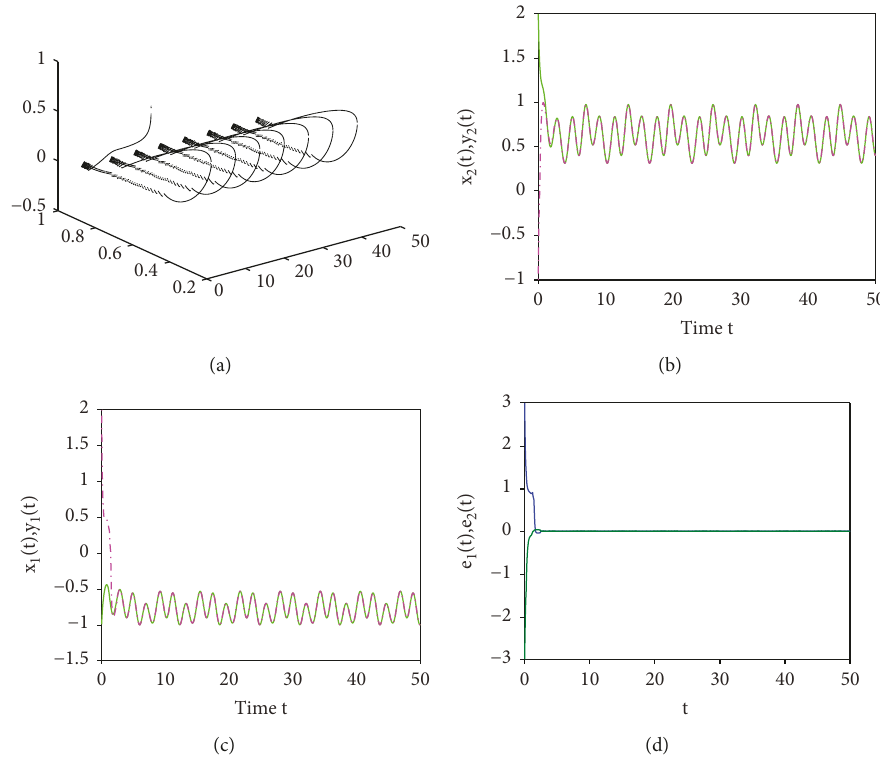
Figure 1: (a) The three-dimensional trajectory of state variables x corresponding response system (34). (d) The time response of the synchronization error between the driver system (34) and corresponding response system with the continuous controller.